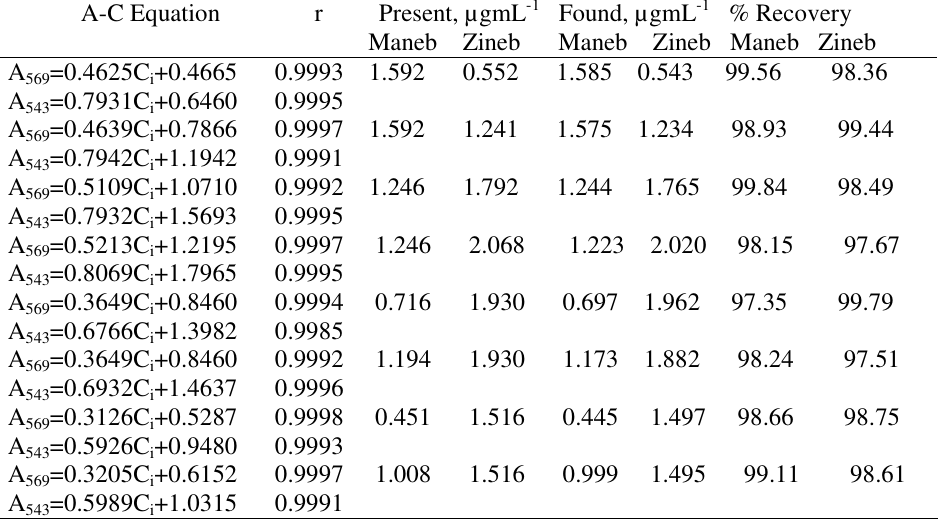
Table 1. Results of several experiments for the analysis of maneb and zineb in synthetic samples by HPSAM